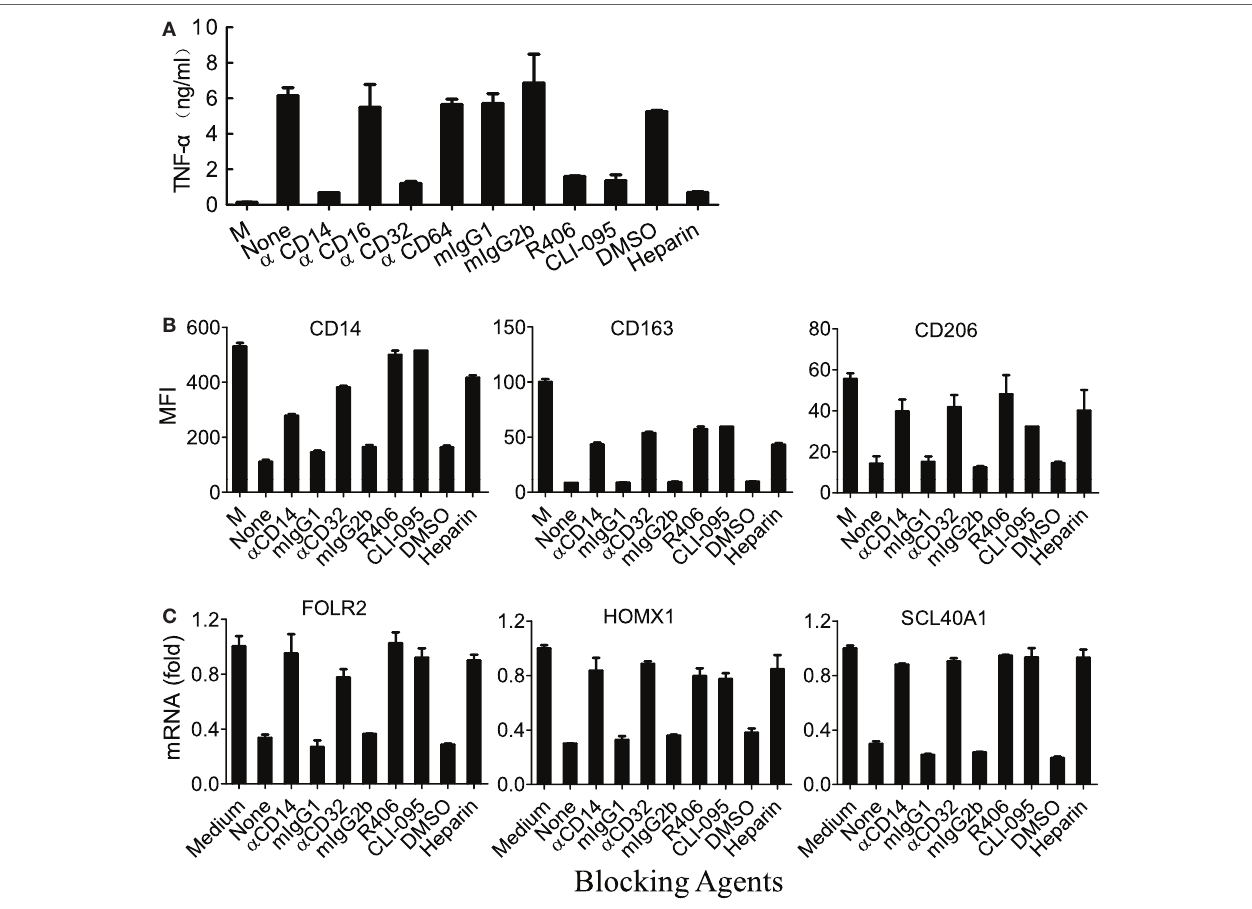
FigUre 5 | M860-IC induced phenotype switching is dependent on CD14 and CD32. (a) (M-CSF)-M2 macrophages were exposed to M860-IC (30 µg/ml) for 18 h in the presence of heparin or R406 (0, 1, 3 µM), mAbs against human CD14, CD16, CD32, CD64, or CLI-095 (5 µM). Isotype-matched irrelevant Abs as well as untreated (M-CSF)-M2 cells (M) were included as controls. TNF α in the culture supernatant was quantitated using ELISAs. (b) (M-CSF)-M2 macrophages were exposed to M860-IC (30 µg/ml) for 18 h in the presence, or absence (None), of anti-CD14 (2 µg/ml), anti-CD32 (5 µg/ml), R406 (3 µM), CLI-095 (5 µM), or heparin (10 µM). Isotype-matched mAbs and DMSO were included as controls. The cells were then stained with fluorescence-labeled mAbs against human CD14, CD163 or CD206 for flow cytometric analysis. The results are shown as mean fluorescence intensity (MFI). (c) The above cells were also harvested and analyzed for mRNA expression of M2-specific markers including ALDH1A2, CLEC5A, INHBA (normalized to GAPDH expression, fold increase compared with un-stimulated control) by quantitative RT-PCR. The results are expressed as mean ± SD performed in parallel and representative of three experiments with different donors.